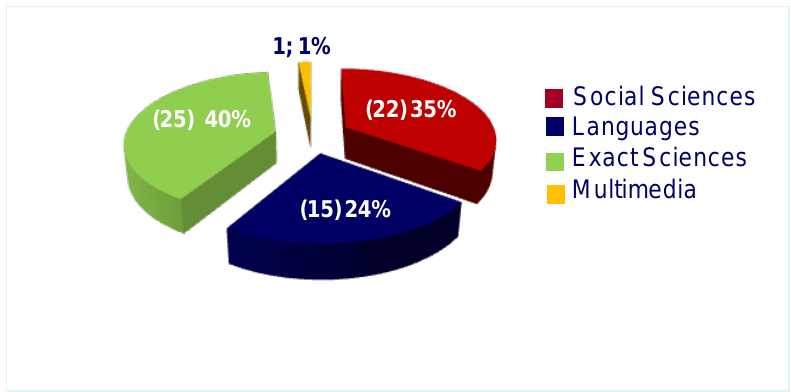
Figure 6. Academic area of origin